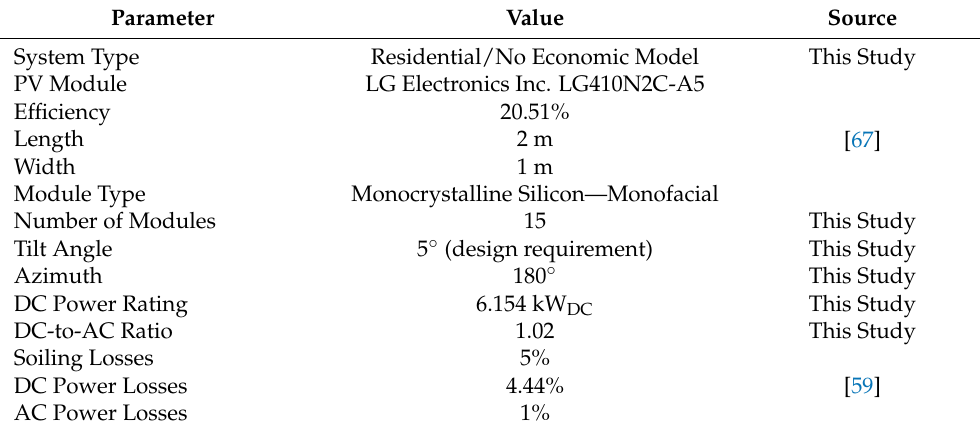
Table 3. Modelling parameters for solar PV in